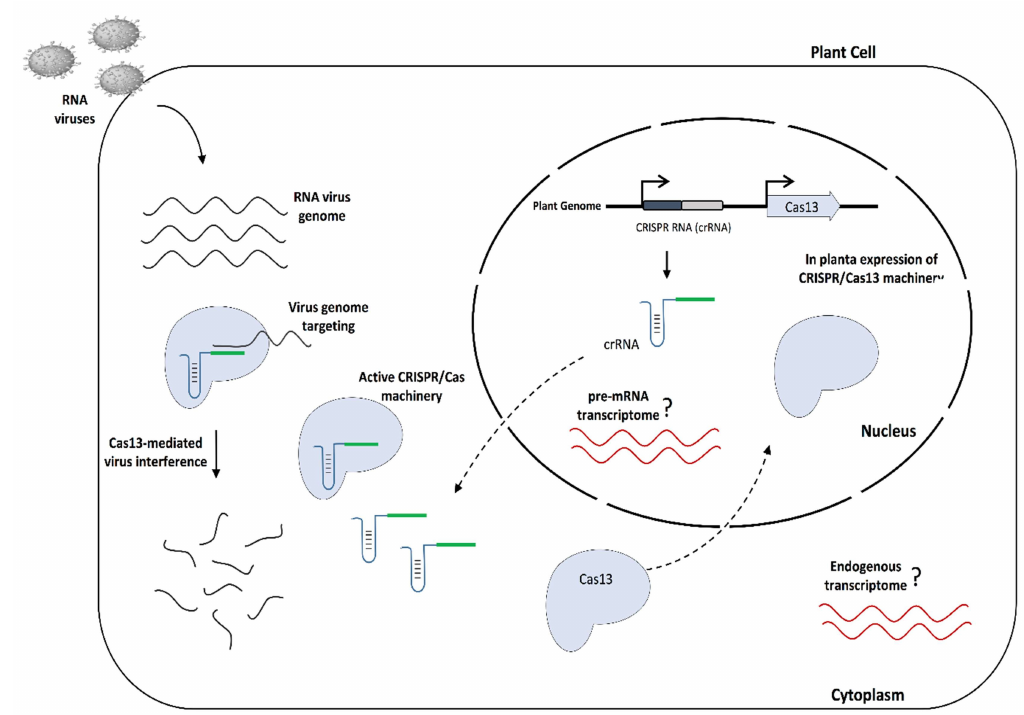
Figure 2. A schematic representation of CRISPR/Cas13-mediated RNA virus interference in plants. The diagram illustrates the mechanism of molecular immunity against RNA viruses in A. thaliana plants expressing CRISPR/Cas13a. When plants are infected with virus, Cas13 guided by virus-targeting crRNA recognizes and degrades the RNA virus genome, providing immunity against the